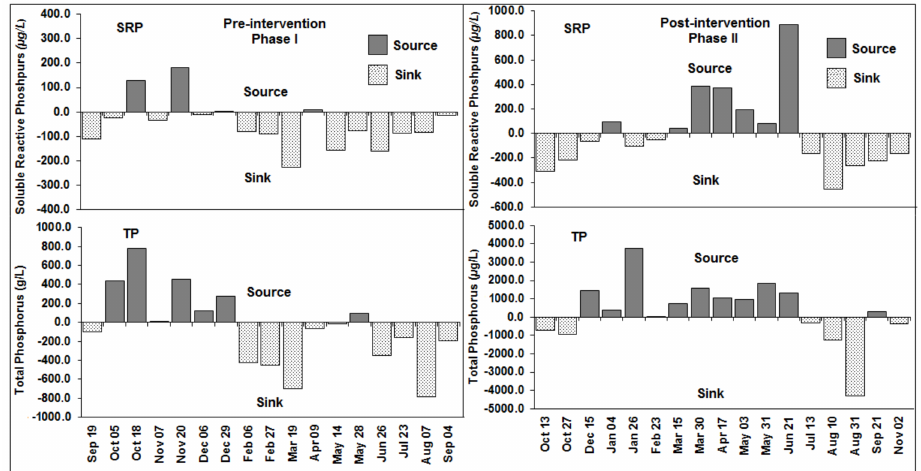
Figure 7. Source and Sink dynamics at Laguna Cartagena from 19 September 2010 to 4 September 2011 (pre-dredging Phase One) and from 13 October 2013 to 2 November 2014 (post-dredging, Phase